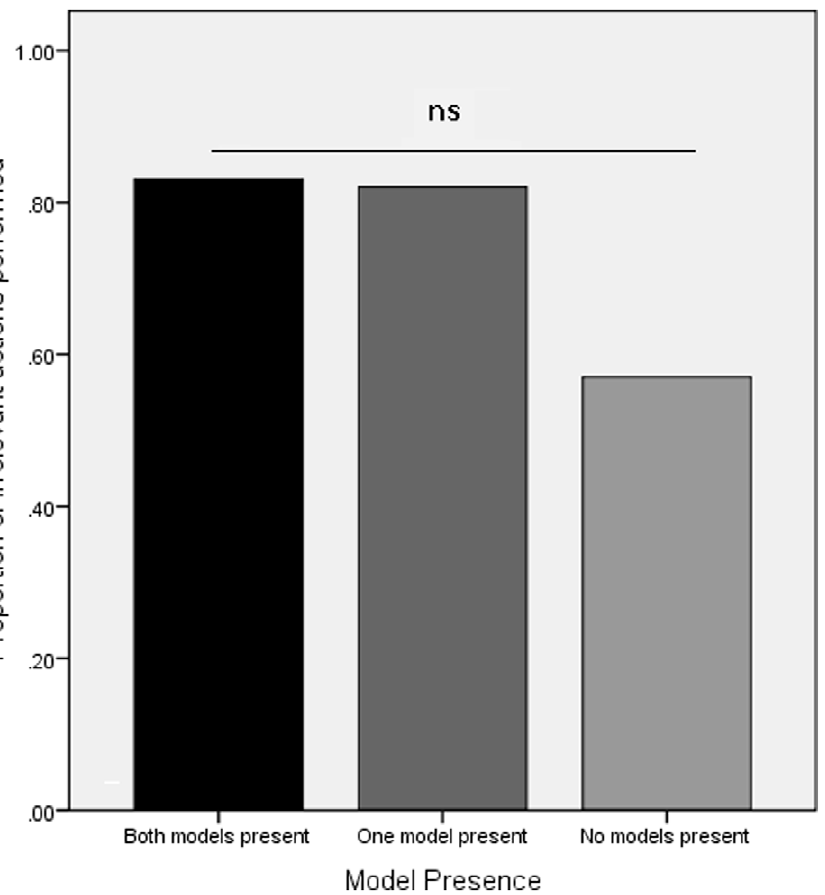
Figure 2. Proportion of irrelevant actions performed in the inefficient strategy conditions of Experiment 1 as a function of model presence.